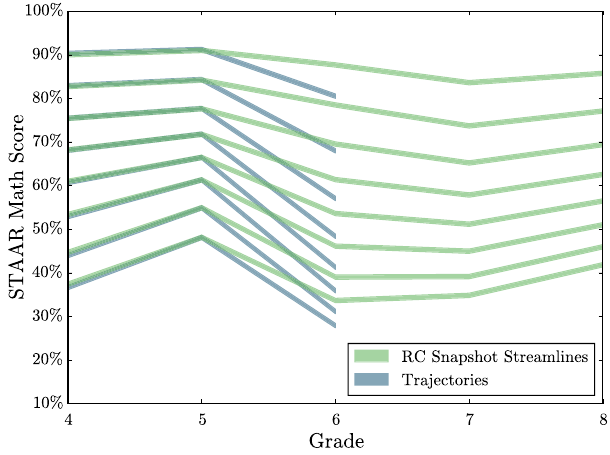
FIG. 13. Partial trajectories for the cohort of students who were 6th graders in 2015 and RC snapshot streamlines for 2012 –